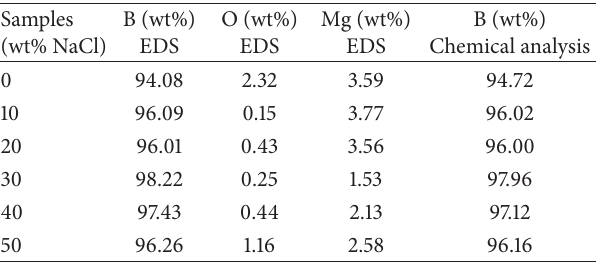
Table 3: Element contents in leached products prepared with different contents of